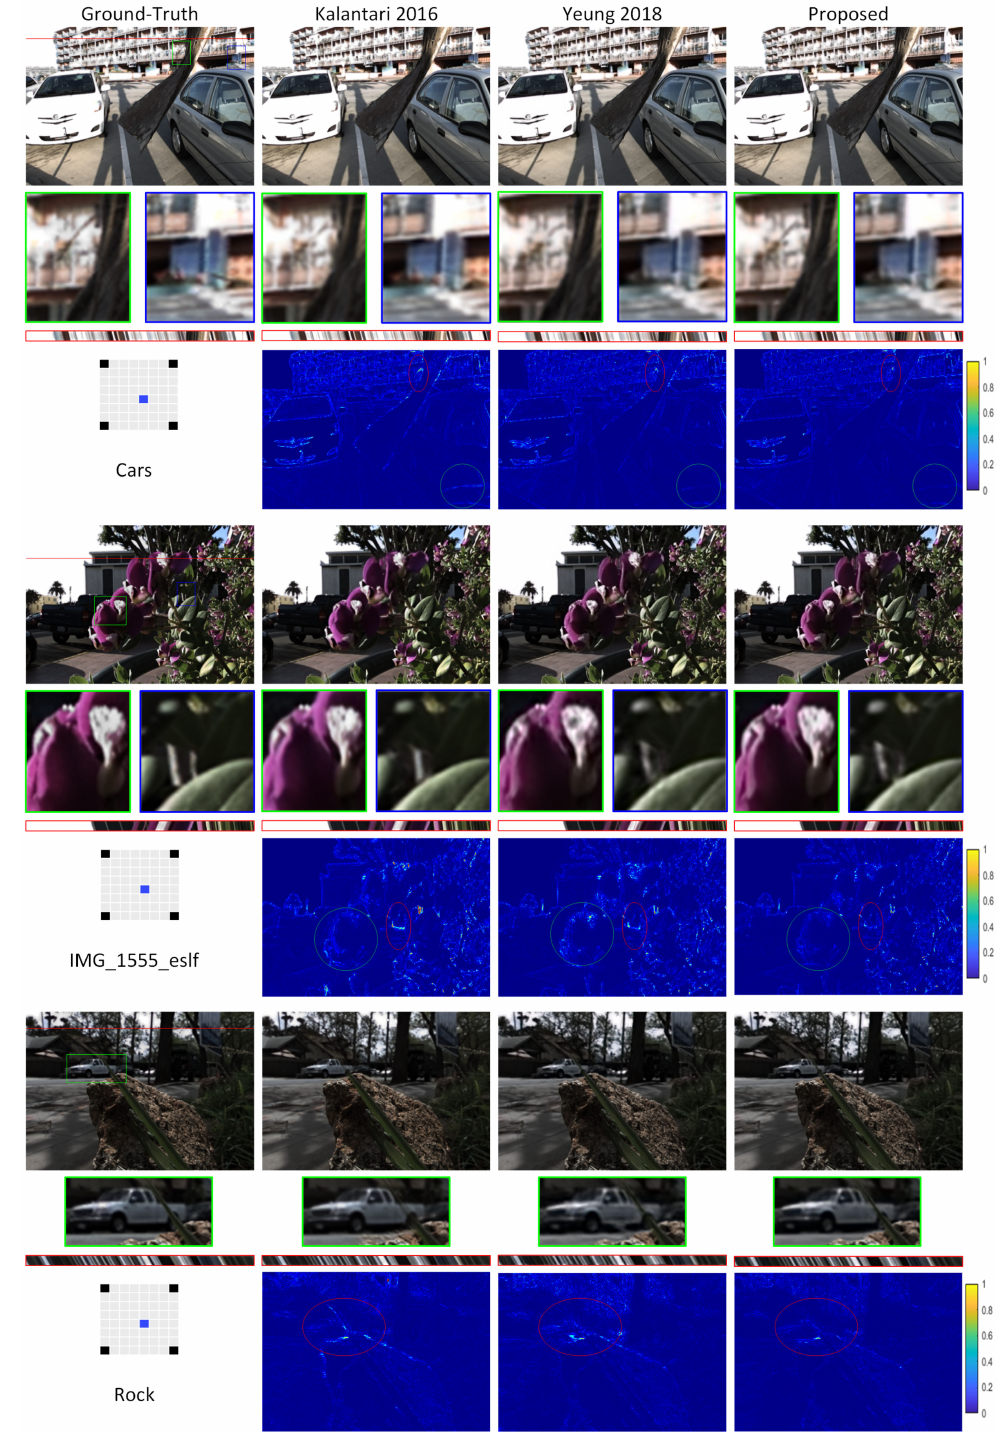
Figure 5. Comparison of LF image reconstruction to other approaches using the relevant ground-truth images on task 1: 2 × 2 − 8 × 8 extrapolation 0 [15,45]. Additionally, error maps are given between the reconstructed LF images and the relevant ground truth images. A diagram shows the input, output, and images to be reconstructed relationships on the left-hand side. Red boxes indicate the extracted EPIs, whereas blue and green boxes indicate a close-up of reconstructed LF image parts. The performance of our strategy is proven through error maps, for example, by the red ellipse around the tree limb in the Cars scene. The red ellipse in the rock scene denotes the complicated area of the automobile with the rock barrier and the longitudinal